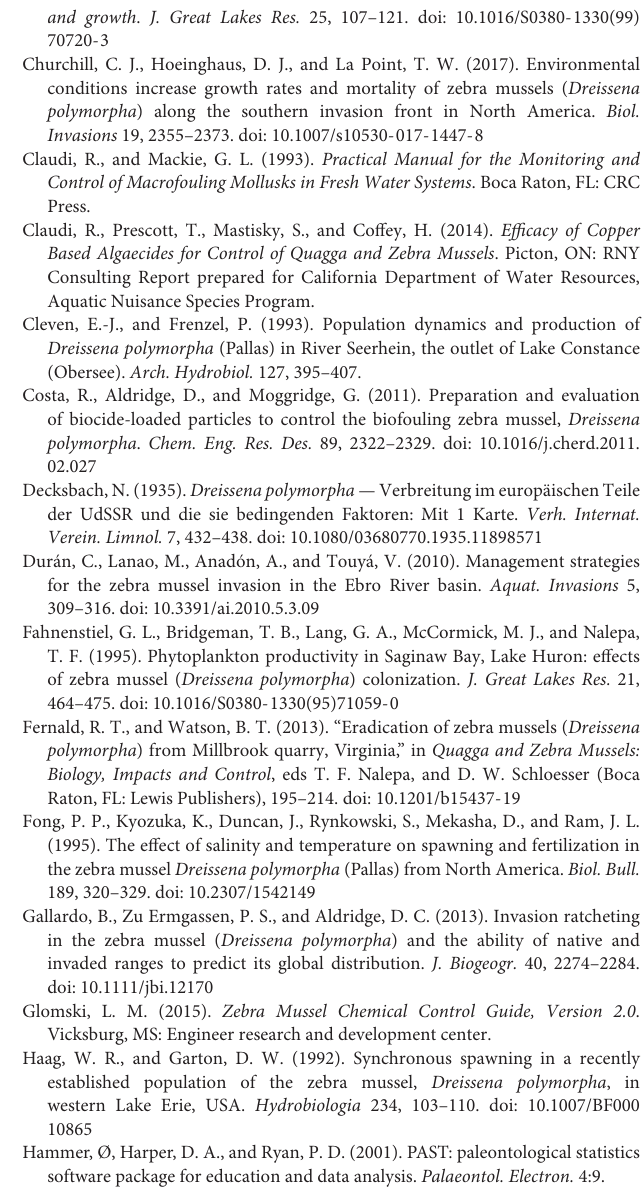
FIGURE S1 | Determination by mixture analysis of the most likely number of zebra mussel cohorts colonizing the experimental panels in Cardiff Bay (undisturbed panels) showing (A) changes in AIC values depending on number of putative cohorts, and (B) mean size ( ± SD) of the smallest cohort (cohort